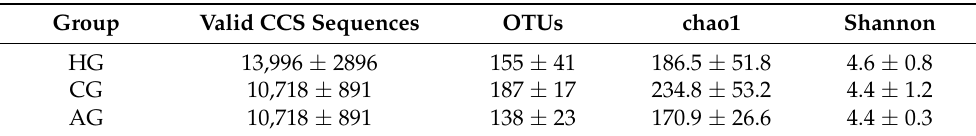
Table 2. Characteristics of sequencing data.